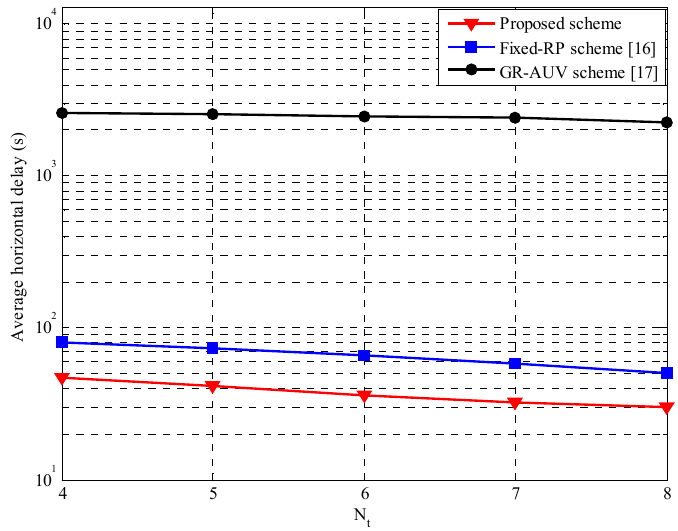
N . N . Figure 12. Average horizontal delay versus the number of tour-points, N t t t